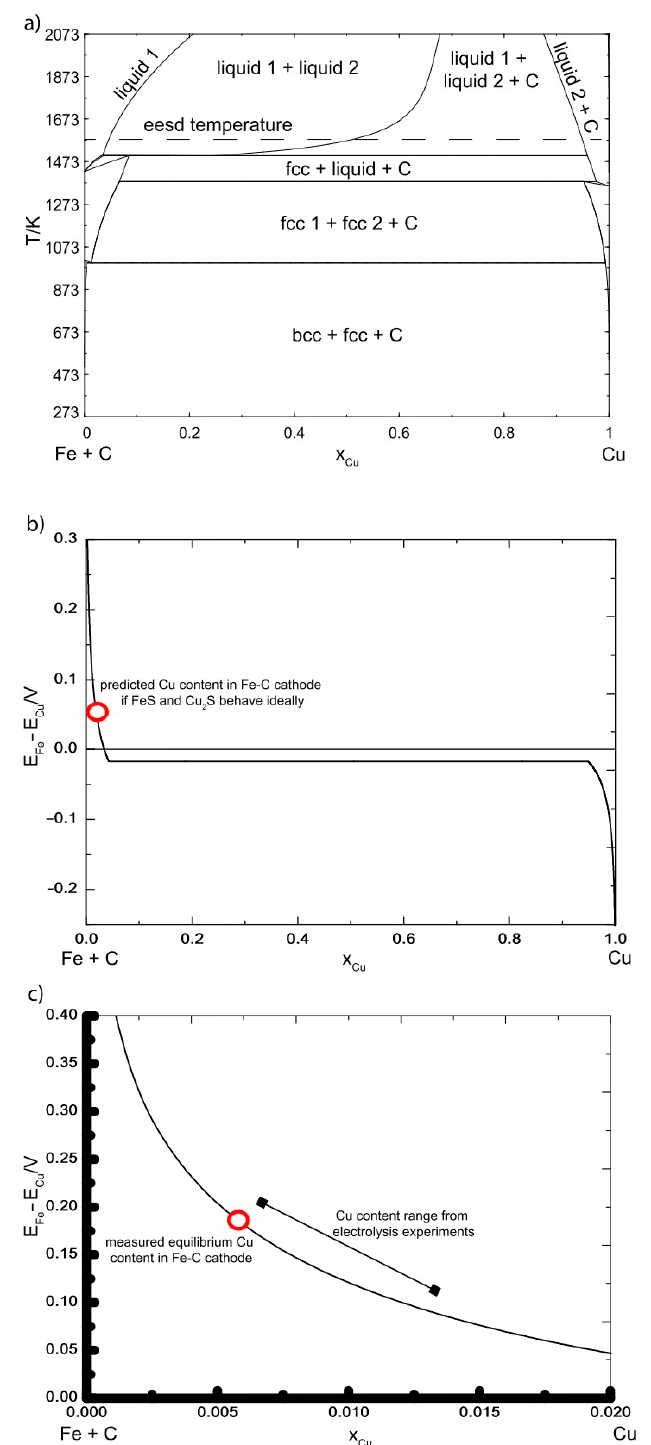
Figure 4. Phase diagram and electrochemical synthesis diagrams for the Fe—Cu—C system revealing potential for the selective deposition of iron and copper from chalcopyrite. ( a ) Fe—Cu—C phase diagram at carbon-saturation, x C /(x Fe +x C ) = 0.17 (4.2 wt%). ( b ) equilibrium electrochemical synthesis diagram for the (Fe—Cu—C)/(FeS—Cu 2 S) system at 1300 °C. At this temperature, cast iron and copper phase separate to form two liquid solutions and solid carbon. ( c ) equilibrium electrochemical synthesis diagram for the (Fe—Cu—C)/(FeS—Cu 2 S) system at 1300 °C for a cast iron cathode containing 4.8 wt% C (19 mol%) showing the measured copper content in the cast iron after equilibration as well as the cathode composition after